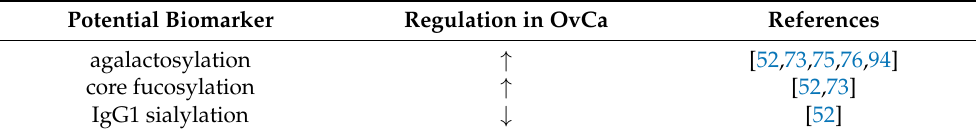
Table 3. IgG glycopeptide biomarkers of ovarian cancer. ↑ - upregulation, ↓ - downregulation.